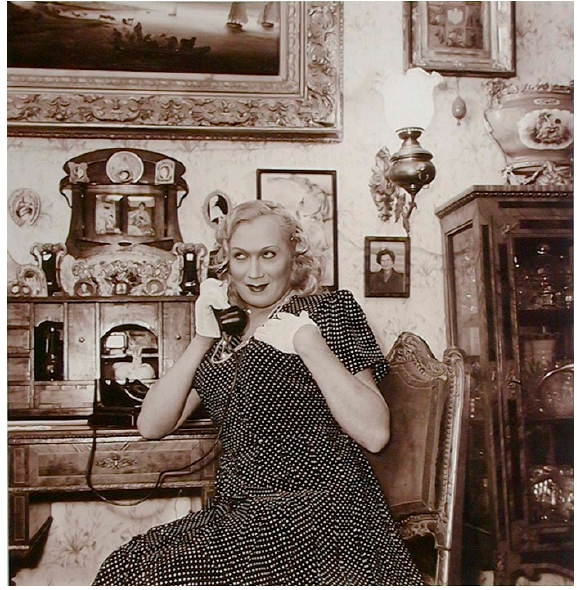
Figure 14. Vlad Mamyshev-Monroe. From the series “Happy Love (Liubov’ Orlova)” (2000); https://vmmf.org/series/view?id=15#work-series-15-3 (accessed on 11 September 2022).